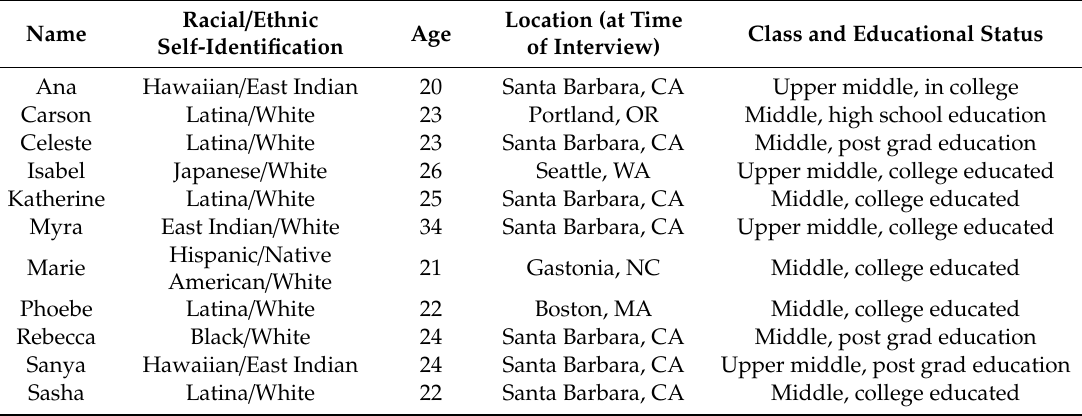
Table A1. Participants, racial / ethnic self-identification, age,